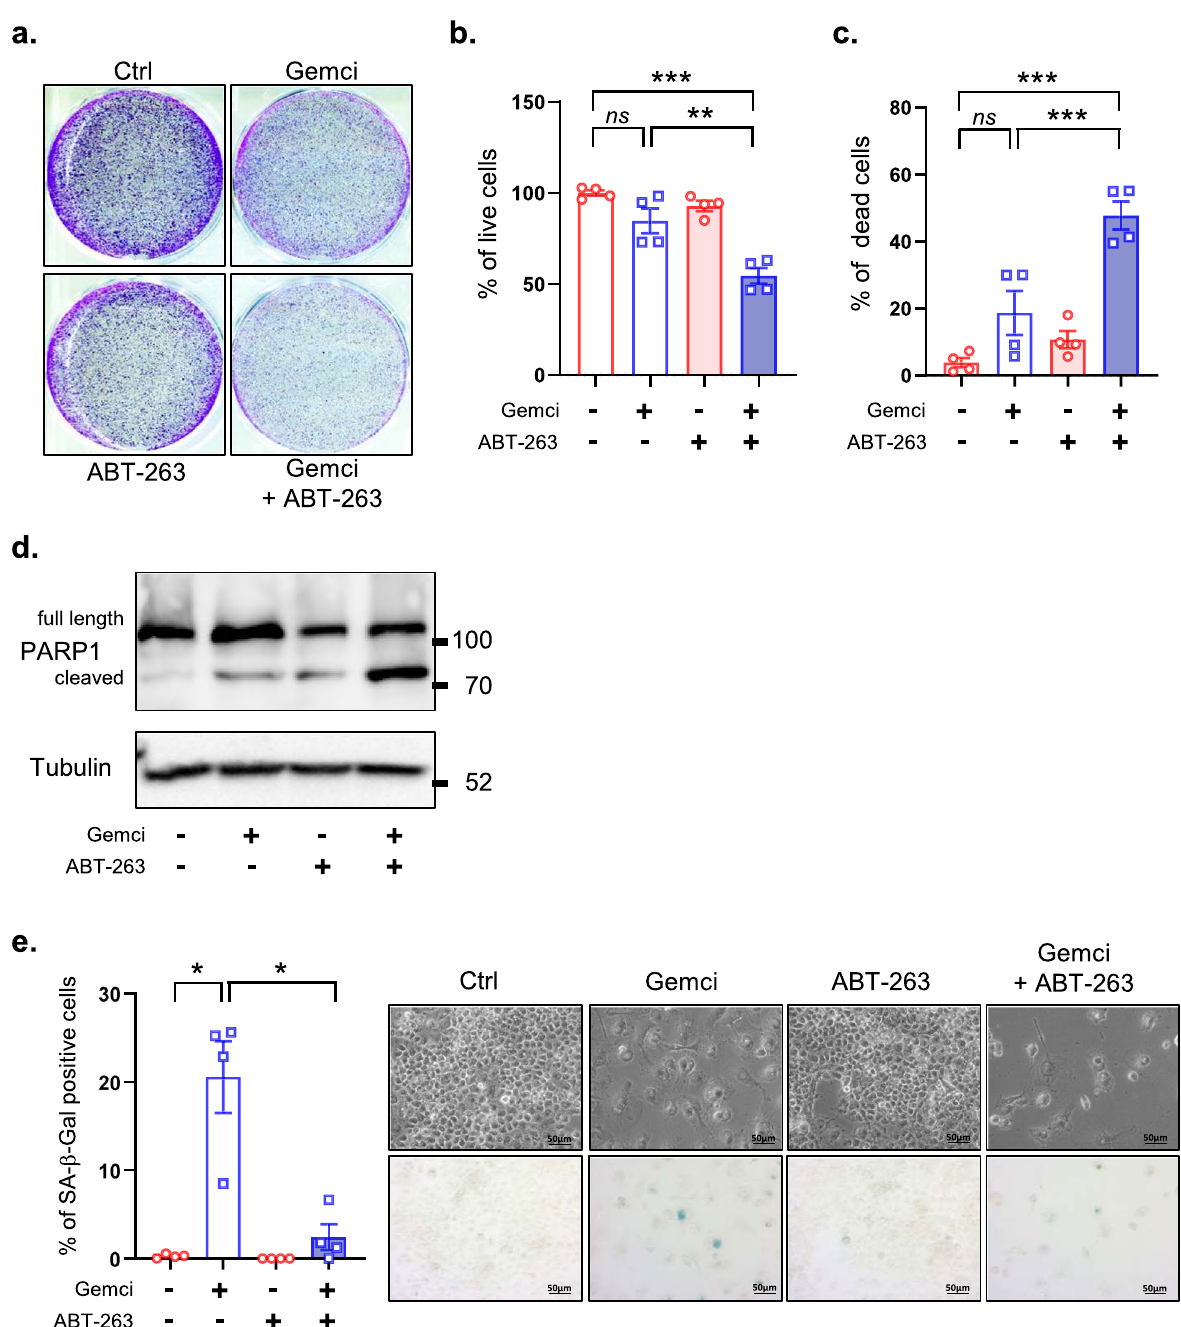
Fig. 5 ABT‑263 kills chemoresistant and senescent‑like Panc1 cells. One day after seeding, Panc1 cells were treated or not with gemcitabine at 620 nM, with or without ABT‑263 at 2.5 μM. Four days later the different assays were performed. a , Representative images of colony assay using Crystal Violet staining 4 days after treatment. b , Percentage of live cells and c , percentage of dead cells using Trypan Blue are shown. ( n / SEM, Unpaired Student t‑test). d , Immunoblot against PARP1 and tubulin, used as a loading control. e , Cells were fixed and stained for SA‑β‑Gal + − activity, and the percentage of positive cells were calculated ( n